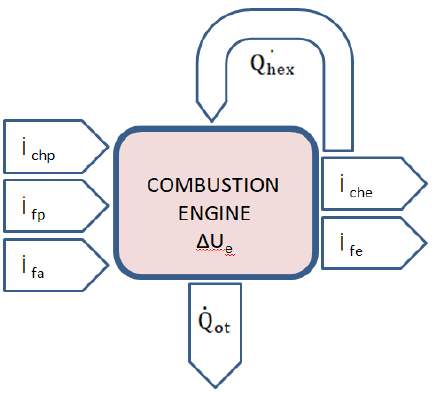
Fig. 7. Scheme of heat balance of the engine including heat coming from exhaust gas